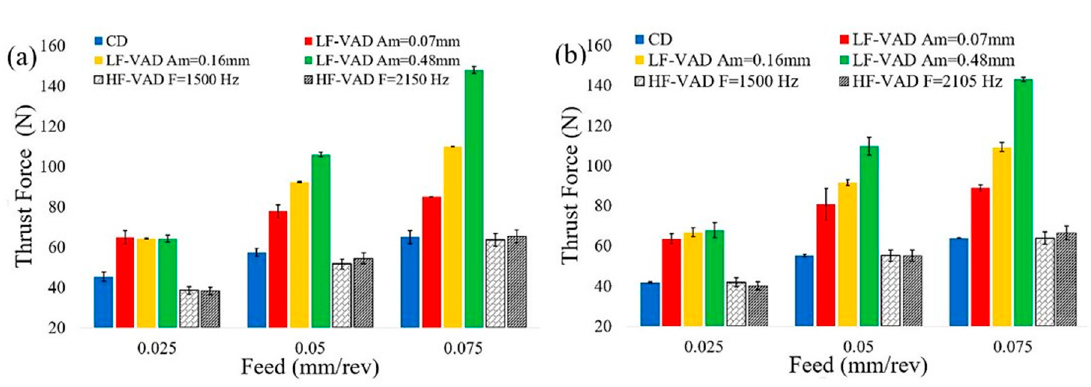
Figure 4. Effect of VAD on the thrust force at ( a ) N = 2000 rpm ( b ) N = 3000 rpm.